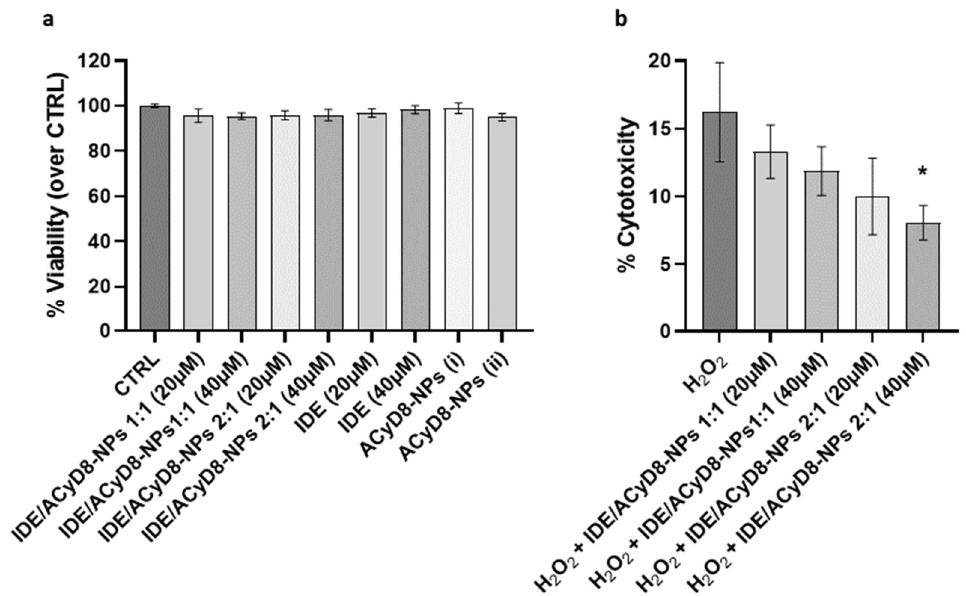
Figure 14. ( a ) Analysis of cell viability of neuronal SH-SY5Y cells treated with IDE/ACyD8-NPs, IDE and ACyD8 for 72 h. Data are presented as mean ± S.D. ( b ) Analysis of cytotoxicity on the same cells pretreated with IDE/ACyD8-NPs and exposed to 30 µ M H 2 O 2 for 72 h. Concentrations in IDE/ACyD8-NPs refers to the actual loading of IDE within NPs. Unloaded ACyD8-NPs (i) and (ii) were tested at the same ACyD8 concentration used for testing the drug-loaded NPs 20 µ M and 40 µ M, respectively. Data are presented as mean ± S.D. One-way ANOVA with Tukey’s multiple comparison test: in ( a ), all data are not statistically different; in ( b ), * p < 0.05 (H 2 O 2 + IDE/ACyD8-NPs 2:1 40 µ M versus H 2 O 2 ).